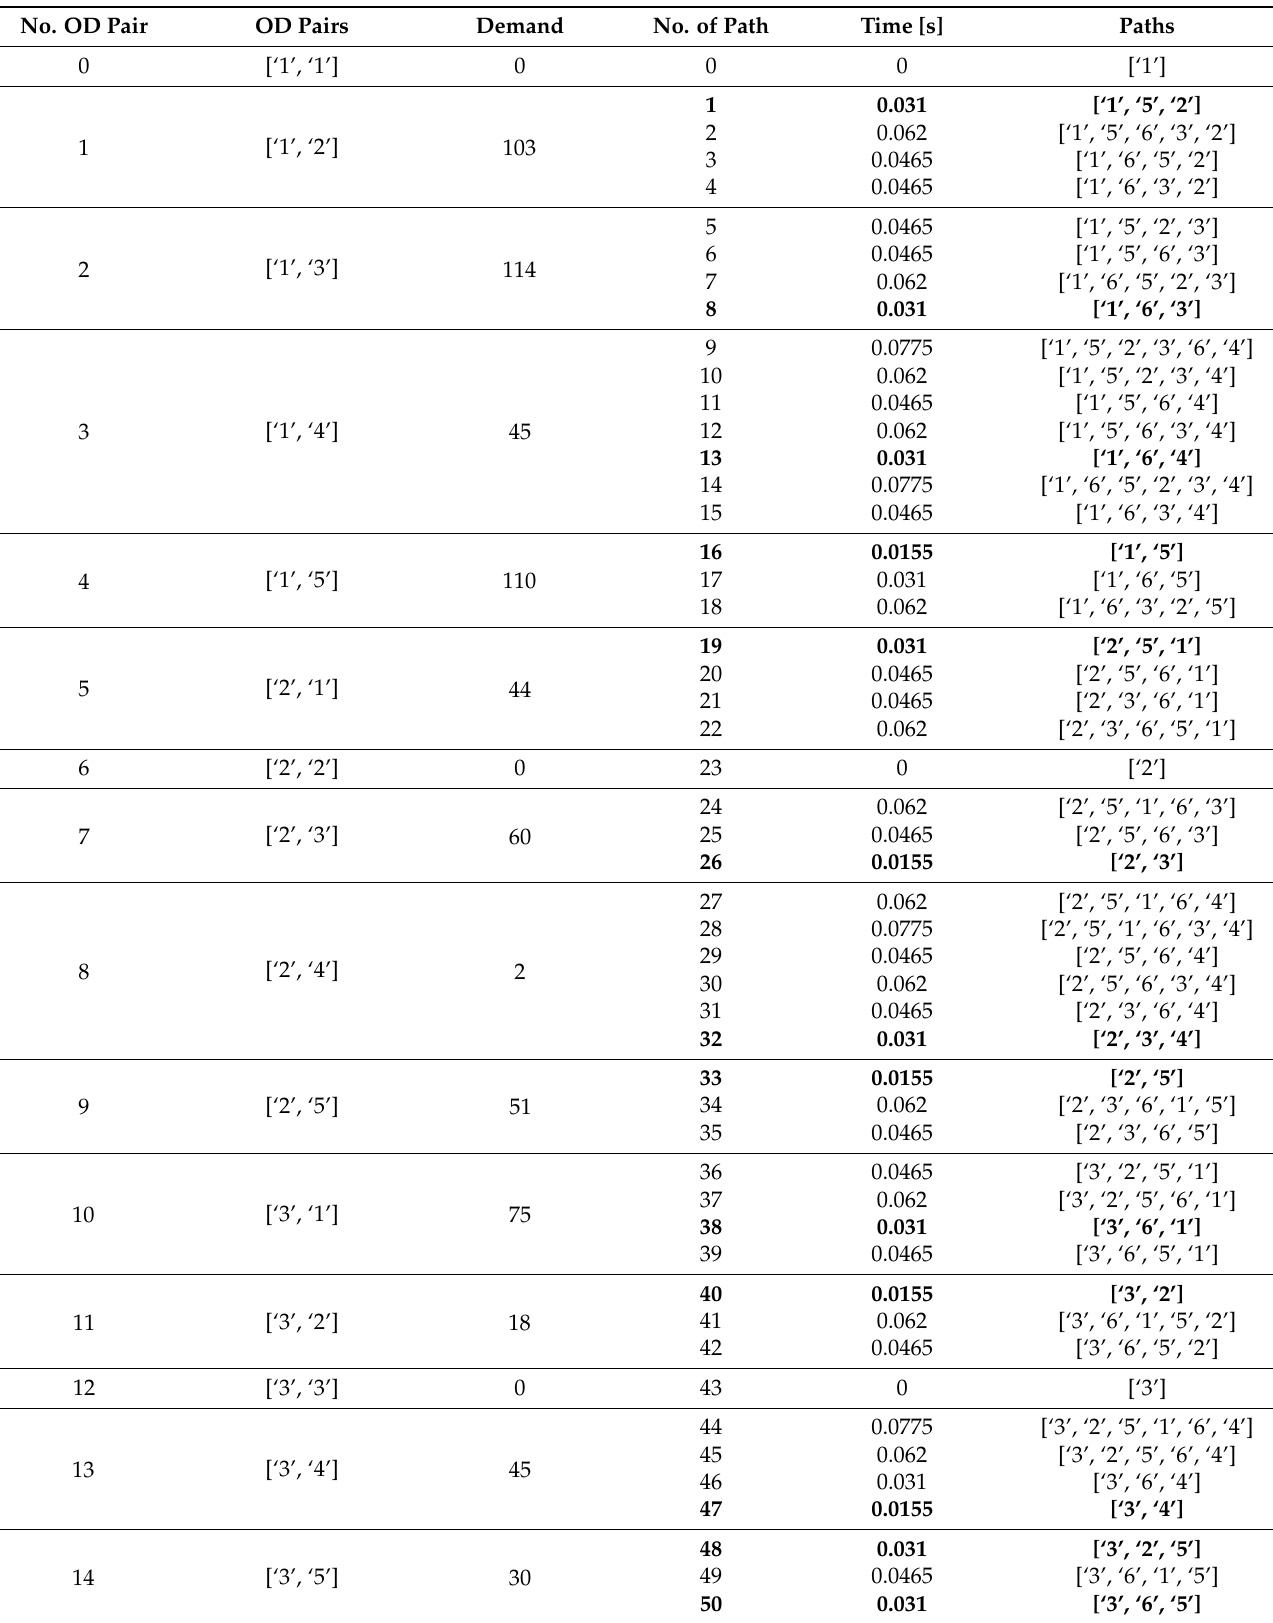
Table 3. Results of paths and travel time information after traffic